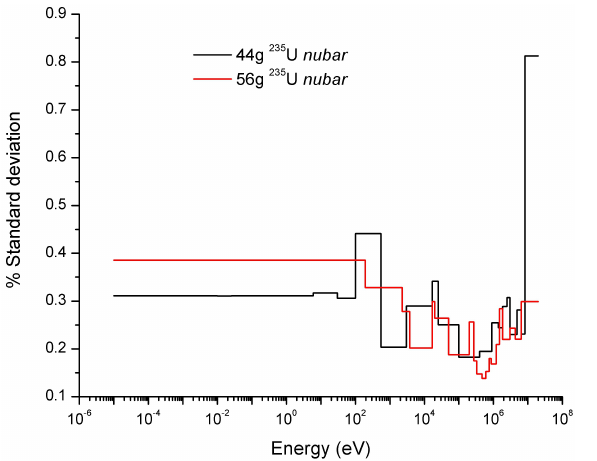
Figure 5. 239 Pu nubar relative standard deviation by energy for reproduced from covariance libraries 44groupcov and 56groupcov.